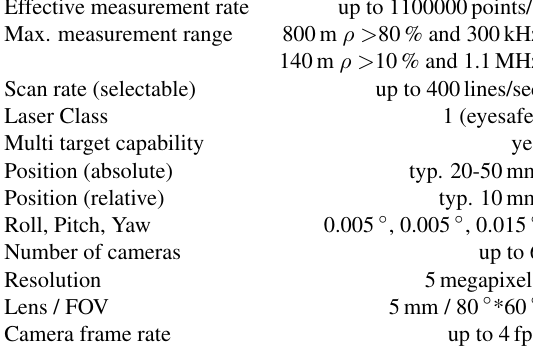
Table 1: Specifications of the MLS system RIEGL